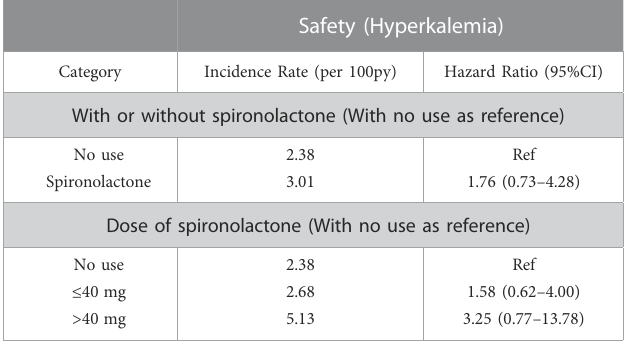
TABLE 8 Association between spironolactone and safety outcomes.